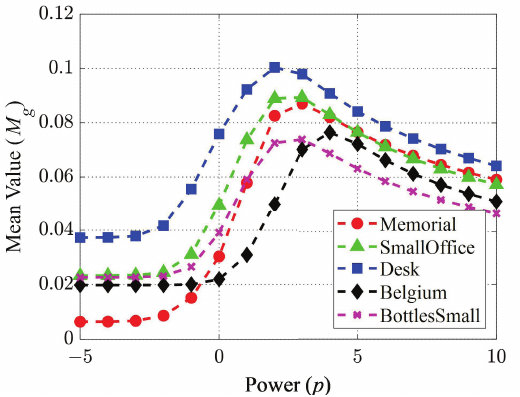
Figure 6. The relationship between the mean value of M g and p